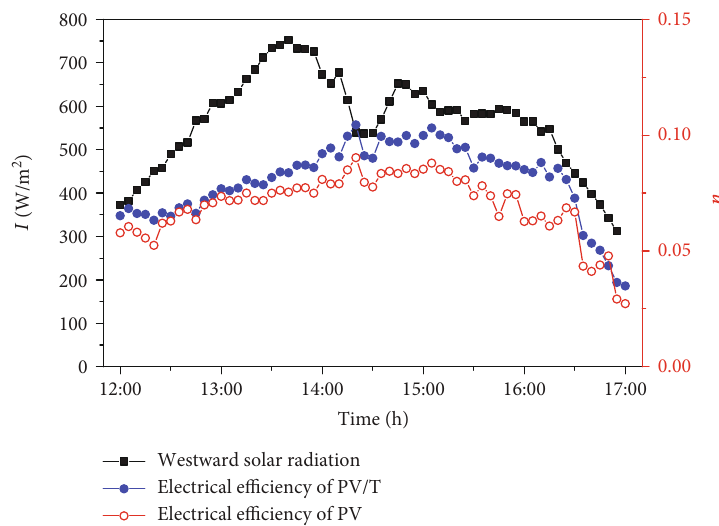
Figure 8: The electrical e ffi ciency of the PV/T and PV façade system.